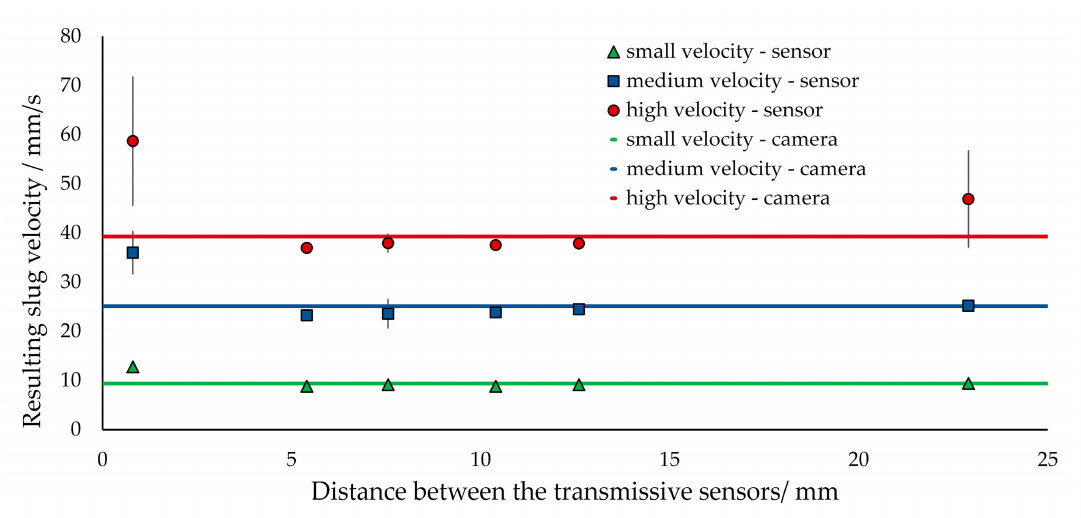
Figure 13. Comparison of measured velocities in a biphasic segmented slug flow (water, 1-hexanol) with respect to di ff erent spacings between the two essential transmissive sensors. The velocities are compared with data from the high-speed camera together with its standard